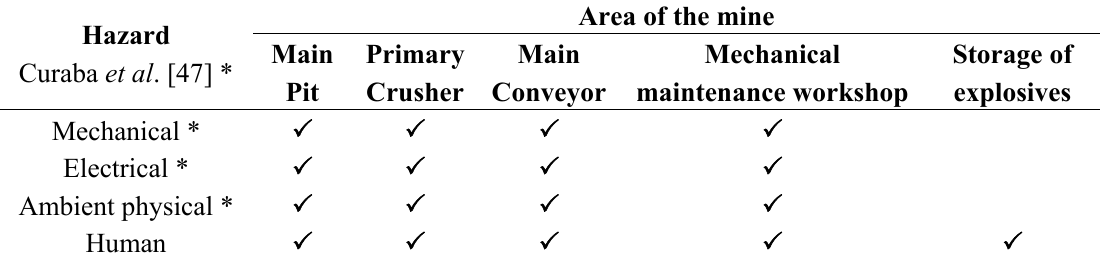
Table 3. Presence of hazards in specific areas of the mine, based on interviews, questionnaires and